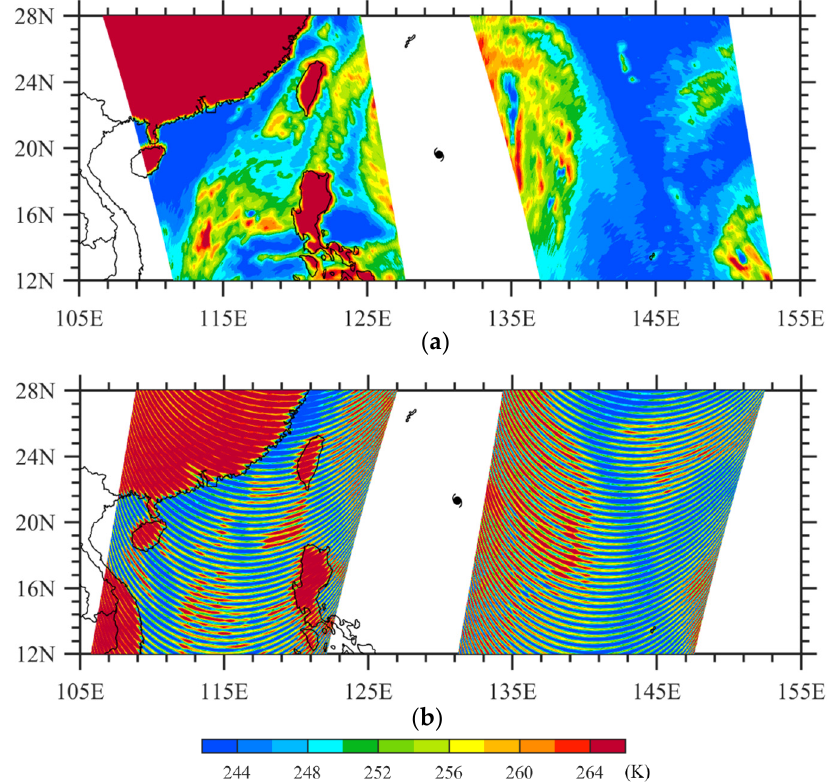
Figure 2. TB observations from F17 SSMIS channel 1 at ( a ) the ascending and ( b ) descending nodes on 20 October 2017. The center position of Typhoon Lan is indicated by a hurricane symbol.